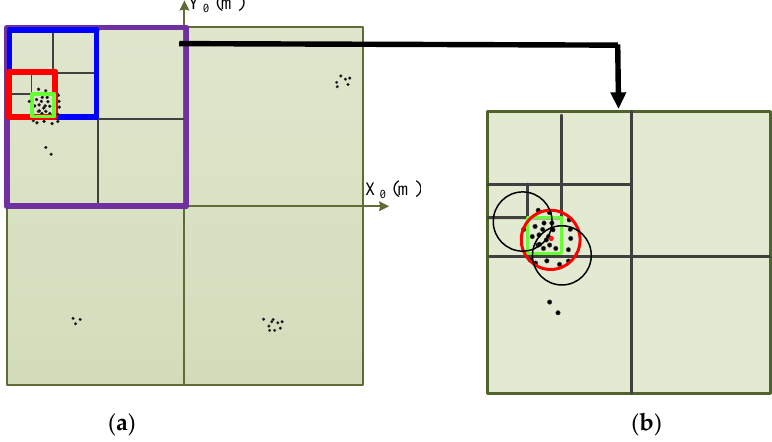
Figure 6. 2D Illustration of clustering procedure in parameter domain: ( a ) approximate peak detection using octree space partitioning strategy, and ( b ) precise peak detection.